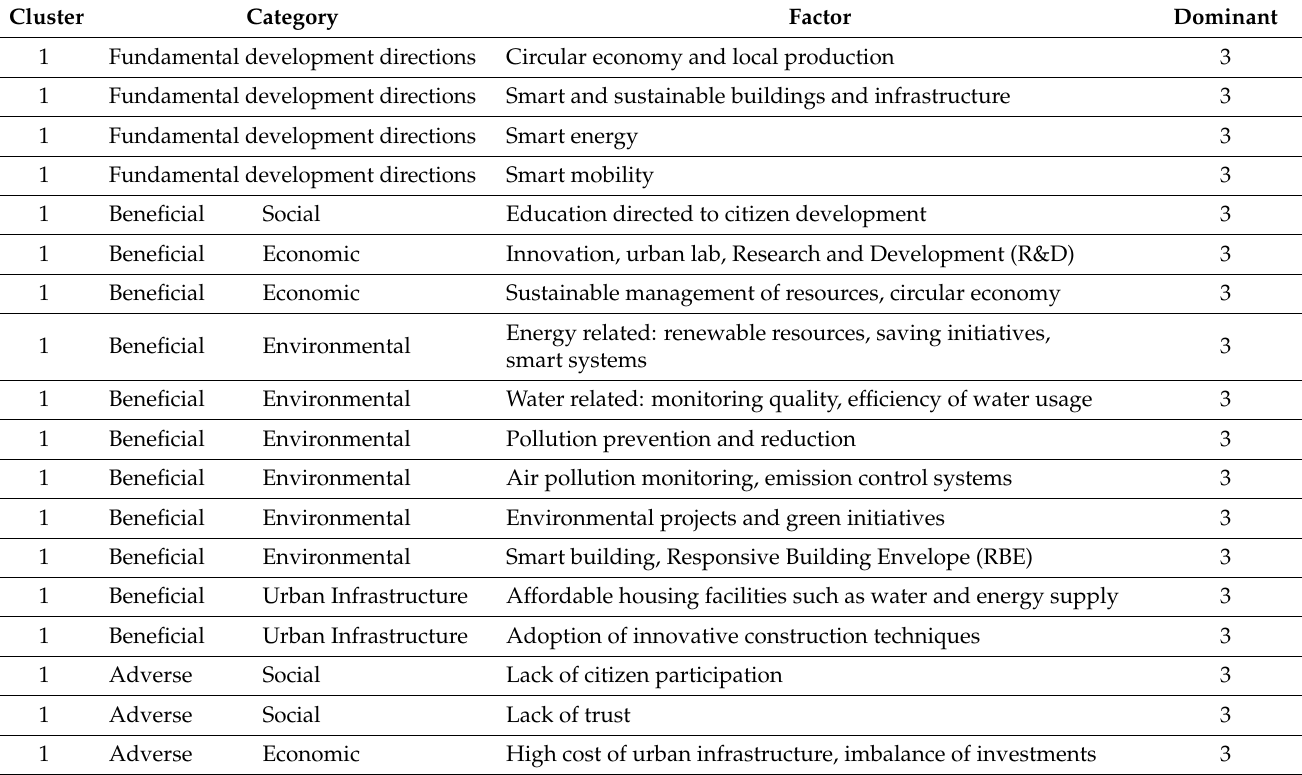
Table A4. Summary of responses to clusters based on the estimated dominant based on the opinion of the experts. Source: Own